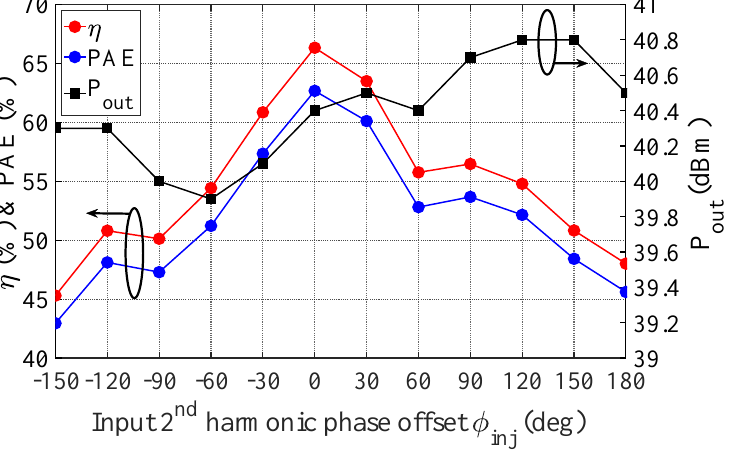
Figure 9. Measured drain efficiency, PAE, and output power using 30 MHz fundamental chirp signal while injecting a 60 MHz time-synchronized second-harmonic chirp signal at 2 GHz.